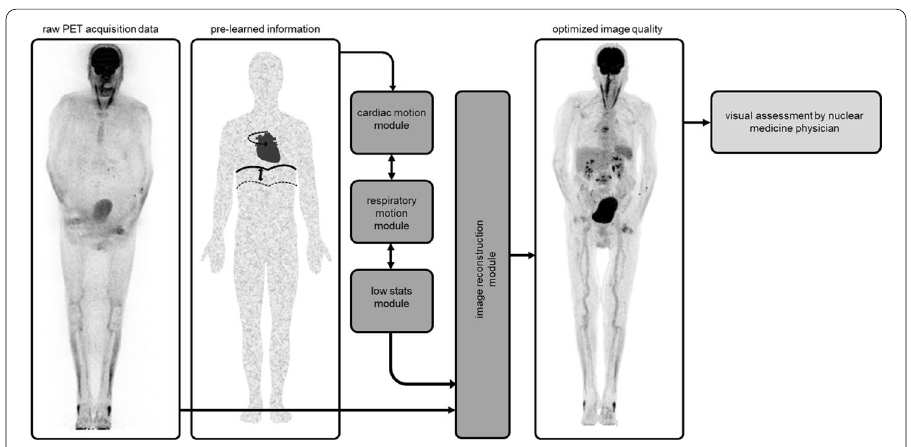
Fig. 2 Potential AI workflow to improve image quality by cardiac and respiratory motion correction. The pre-learned, highly standardized movements of the heart and the lung can be integrated in the image reconstruction in order to optimize the image quality leading to advantages in the visual assessment by the nuclear medicine